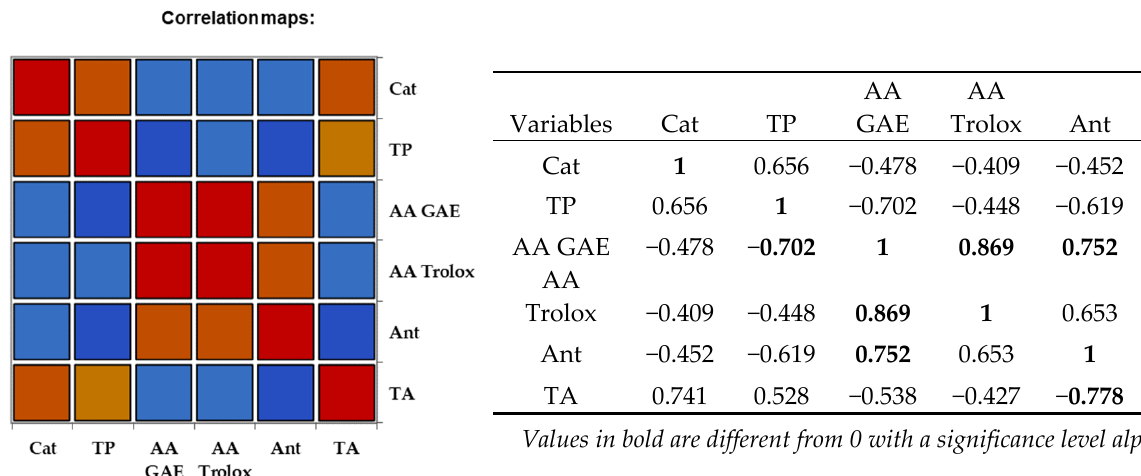
Figure 2. Pearson correlation between the bioactive properties of different grape pomaces (red color: positive correlations and blue color: negative corelations).